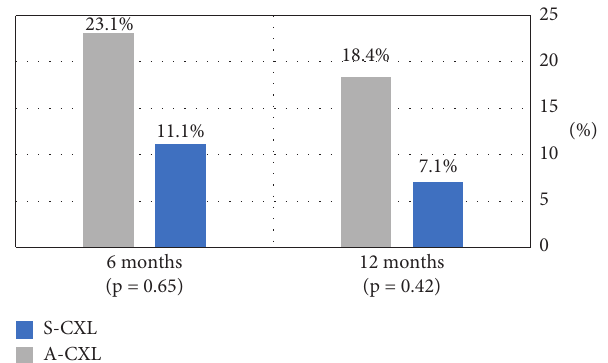
Figure 2: Regression of keratoconus in the study population at 6 and 12 months after CXL. Regression is defined as a reduction of > 1 D in K max. . A-CXL: accelerated cross-linking; S-CXL: standard cross-linking; D: diopter; KC: